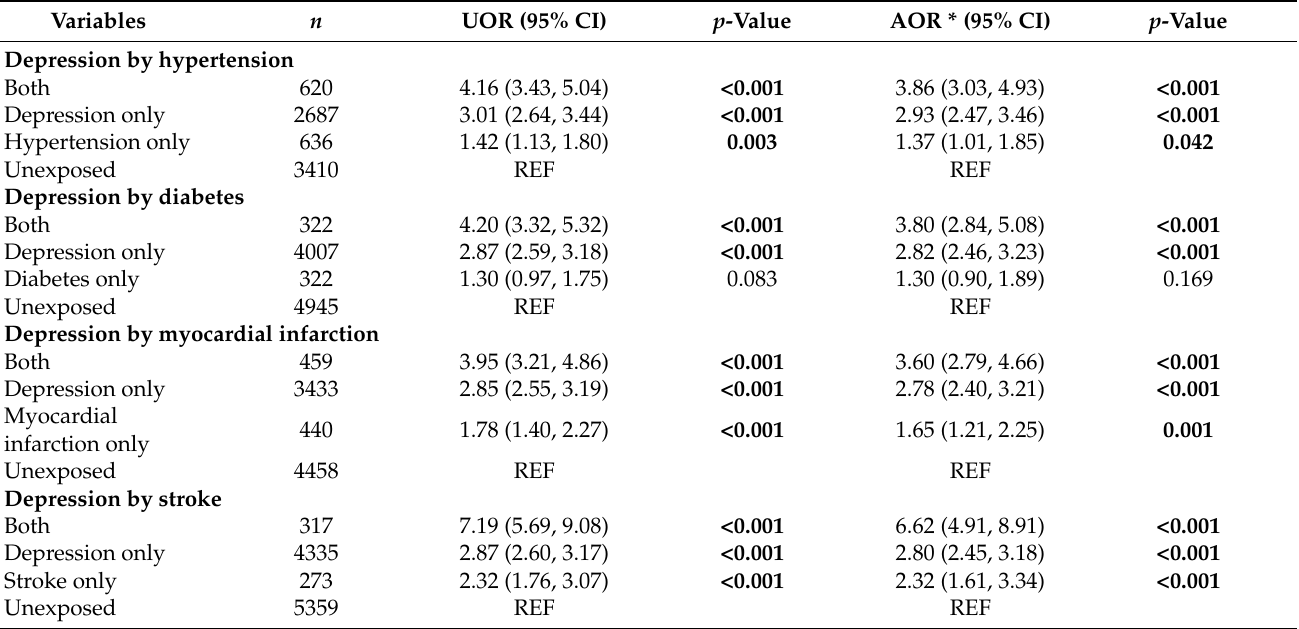
Table 5. The risk of functional impairment according to depression and comorbid vascular disease (activity of daily living).